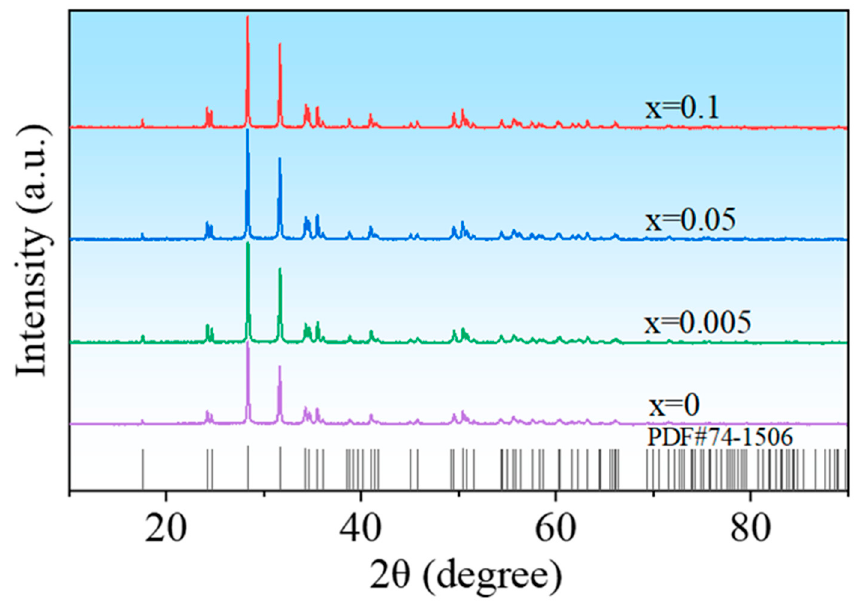
Figure 3. XRD patterns of the ceramic samples prepared via the solid-state reaction method.